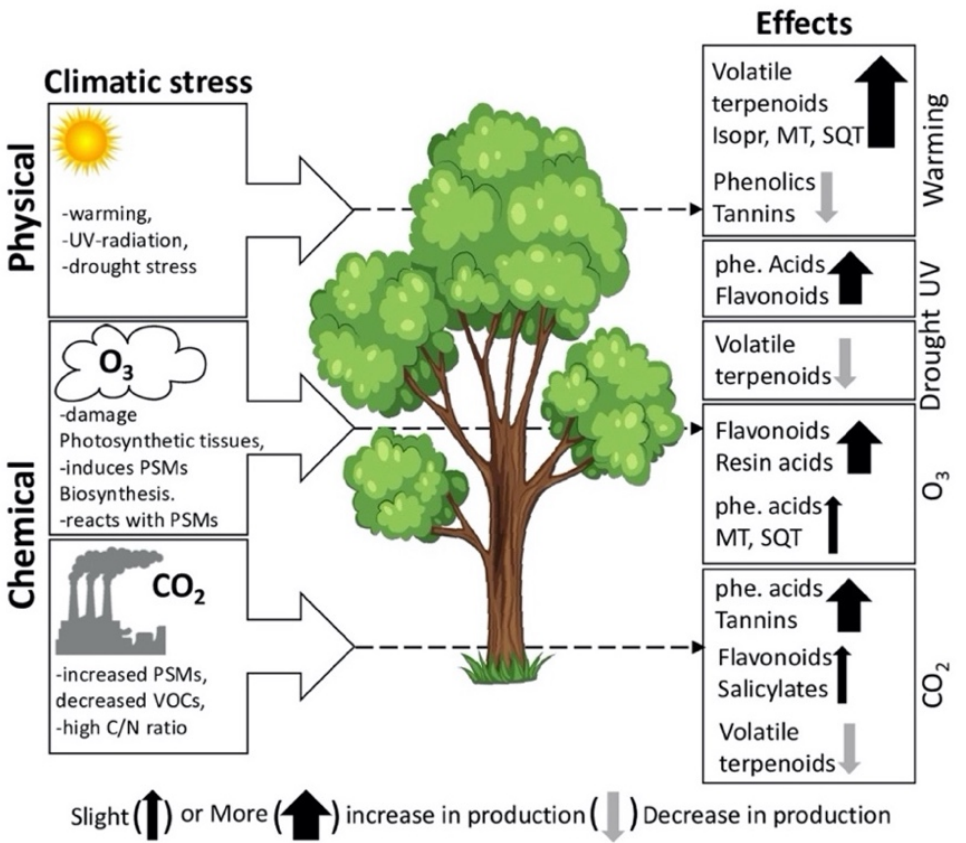
Figure 5. Abiotic stresses and their influence on the types of secondary metabolites in plants (adapted from [94–97]). Abbreviations: UV radiation = ultraviolet radiation; PSMs = plant secondary metabolites; O 3 = ozone; CO 2 = carbon dioxide; Isopr = isoprenoids; MT = monoterpenes; SQT = sesquiterpenes; phe. acids = phenolic acids.